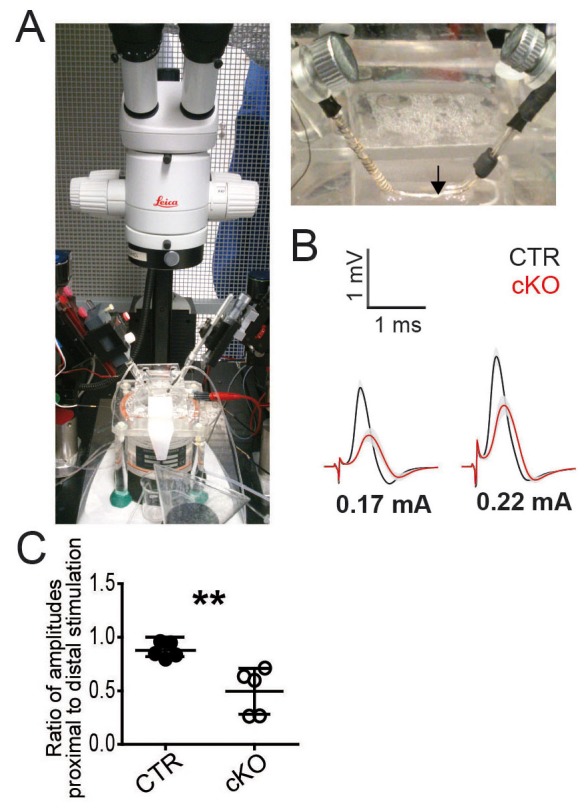
Electrophysiology of mouse sciatic nerves.(A) Photographs of electrophysiology setup with a pair of suction electrodes. (B) Pex5 mutant nerves display smaller and delayed responses when elicited at stimulus intensities of 0.17mA (left) or 0.22mA (right). (C) In vivo electrophysiology of controls and PEX5 cKO shows a greater decline of the compound muscle action potential (CMAP) amplitudes measured at more proximal versus distal stimulation indicating conduction blocks. The ratios of the amplitudes elicited by proximal vs. distal stimulation are depicted. Statistics: n = 5, means ± s.d. **p<0.01, Student’s T-test.